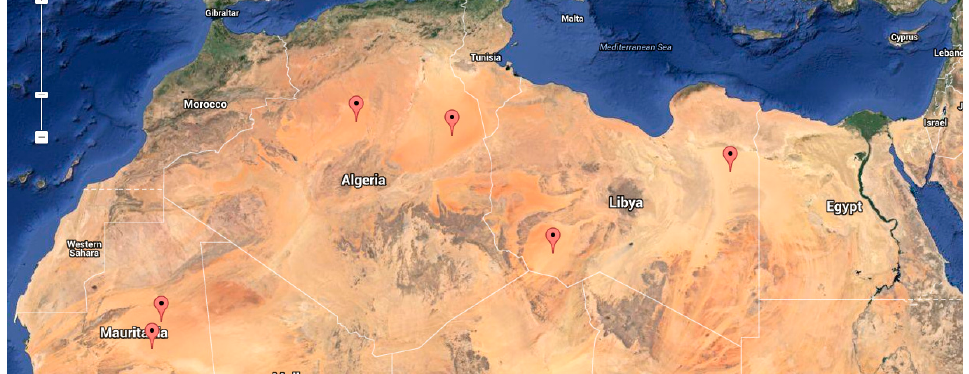
Figure 9. The North Africa surface above is a mixture of rock and desert and is non ‐ homogeneous in reflectance. The bright homogeneous region in the center of this image is CEOS site Libya ‐ 1.